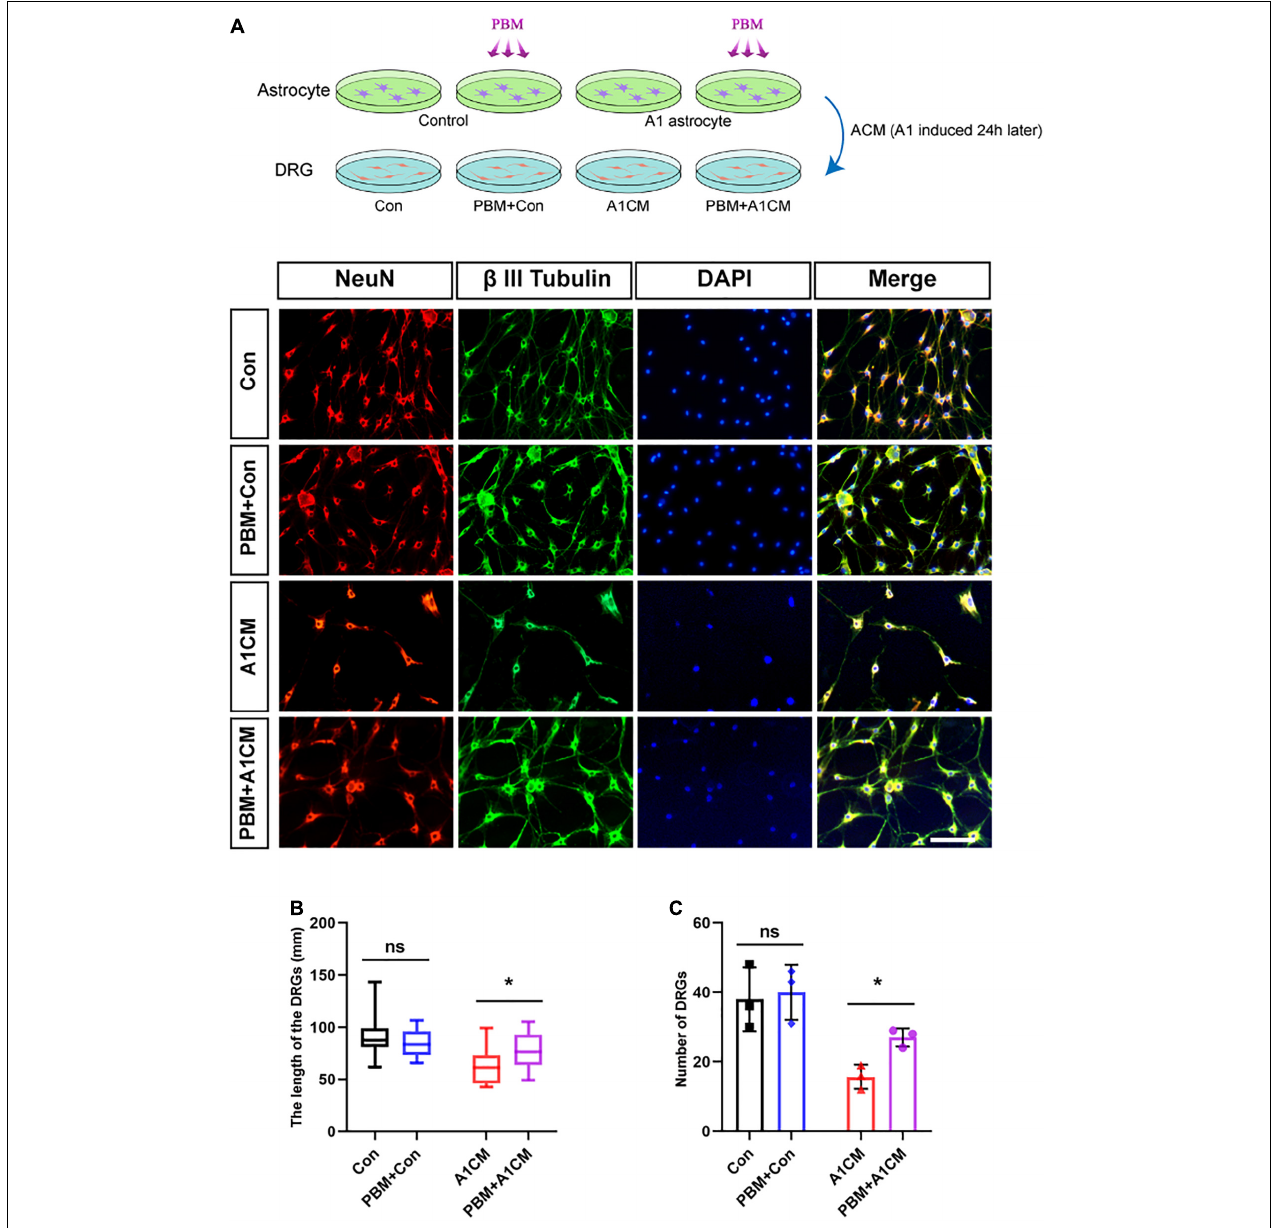
FIGURE 6 | Photobiomodulation alleviated the neurotoxic effect of A1 astrocytes on DRG neurons. (A) DRG neurons treated with ACM collected 24 h after different treatments. Con, medium from control resting astrocytes; Con + PBM: medium from resting astrocytes treated with PBM; A1CM, medium from A1 astrocytes; PBM + A1CM, medium from A1 astrocytes treated with PBM. Representative immunofluorescence images of NeuN (red) and β III tubulin (green) in DRG neurons. Scale bar: 100 mm. (B,C) The length of axons in a single neuron and the number of neurons per field were analyzed. Five visual fields from each sample